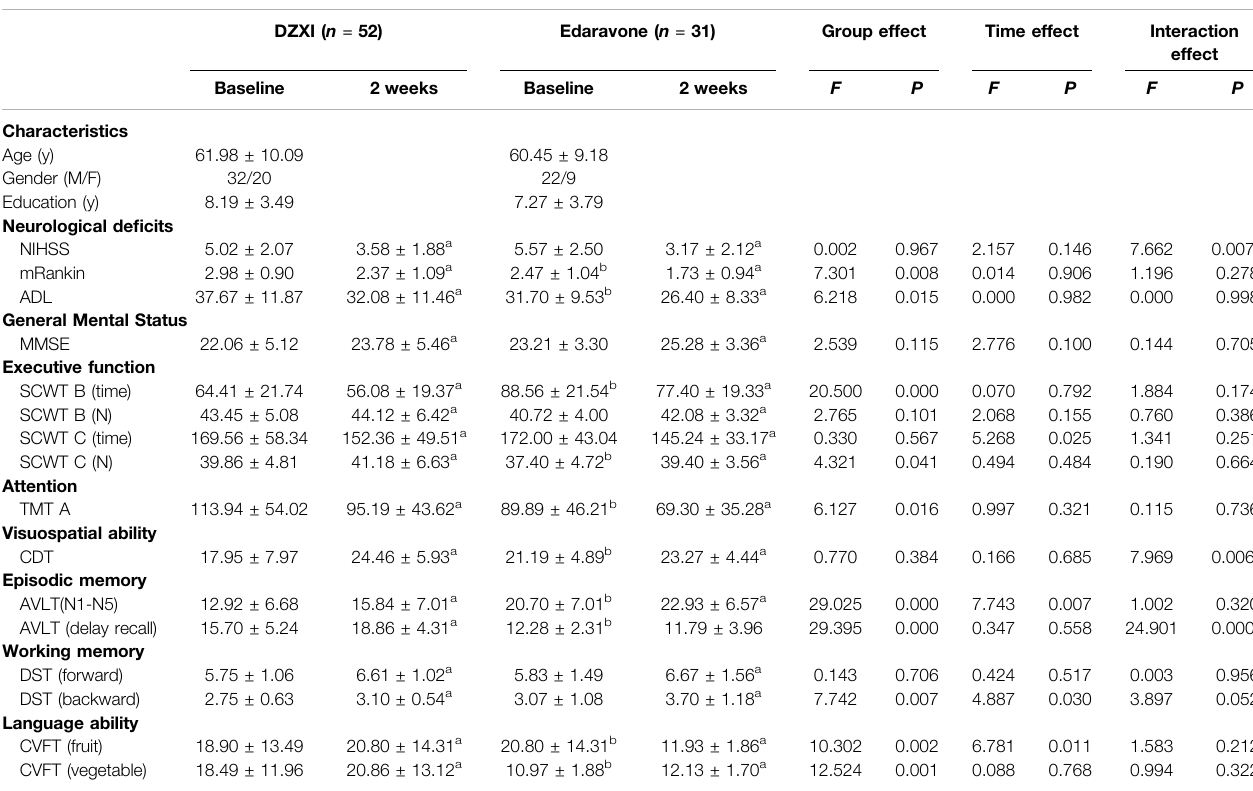
TABLE 1 | Demographics and neuropsychological test scores (Mean ±